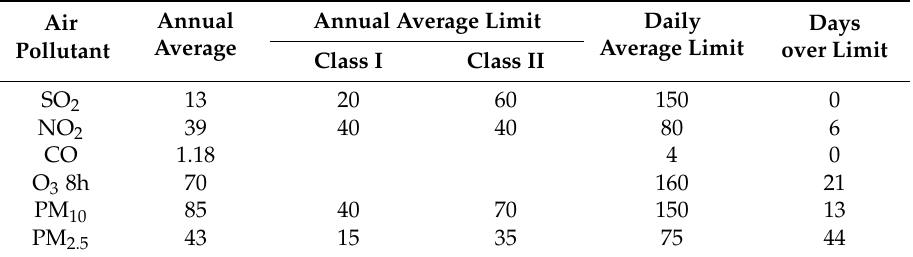
Table 1. Statistics of annual average and daily average concentrations for air pollutants in Shenzhen from March 2013 to February 2014 (mg/m 3 for CO, µ g/m 3 for